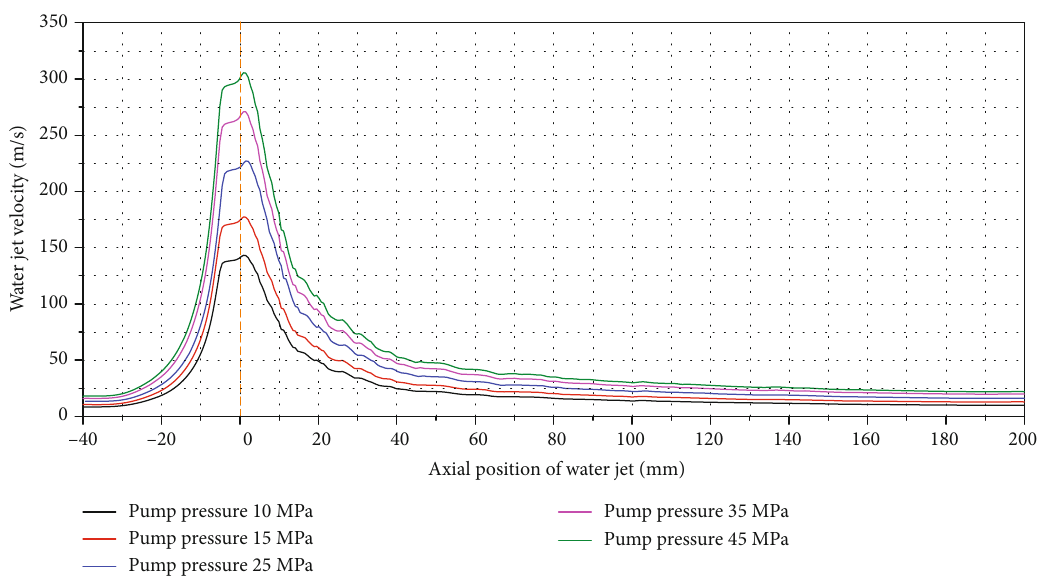
Figure 13: Variations of jet velocity on the jet axis at di ff erent pump